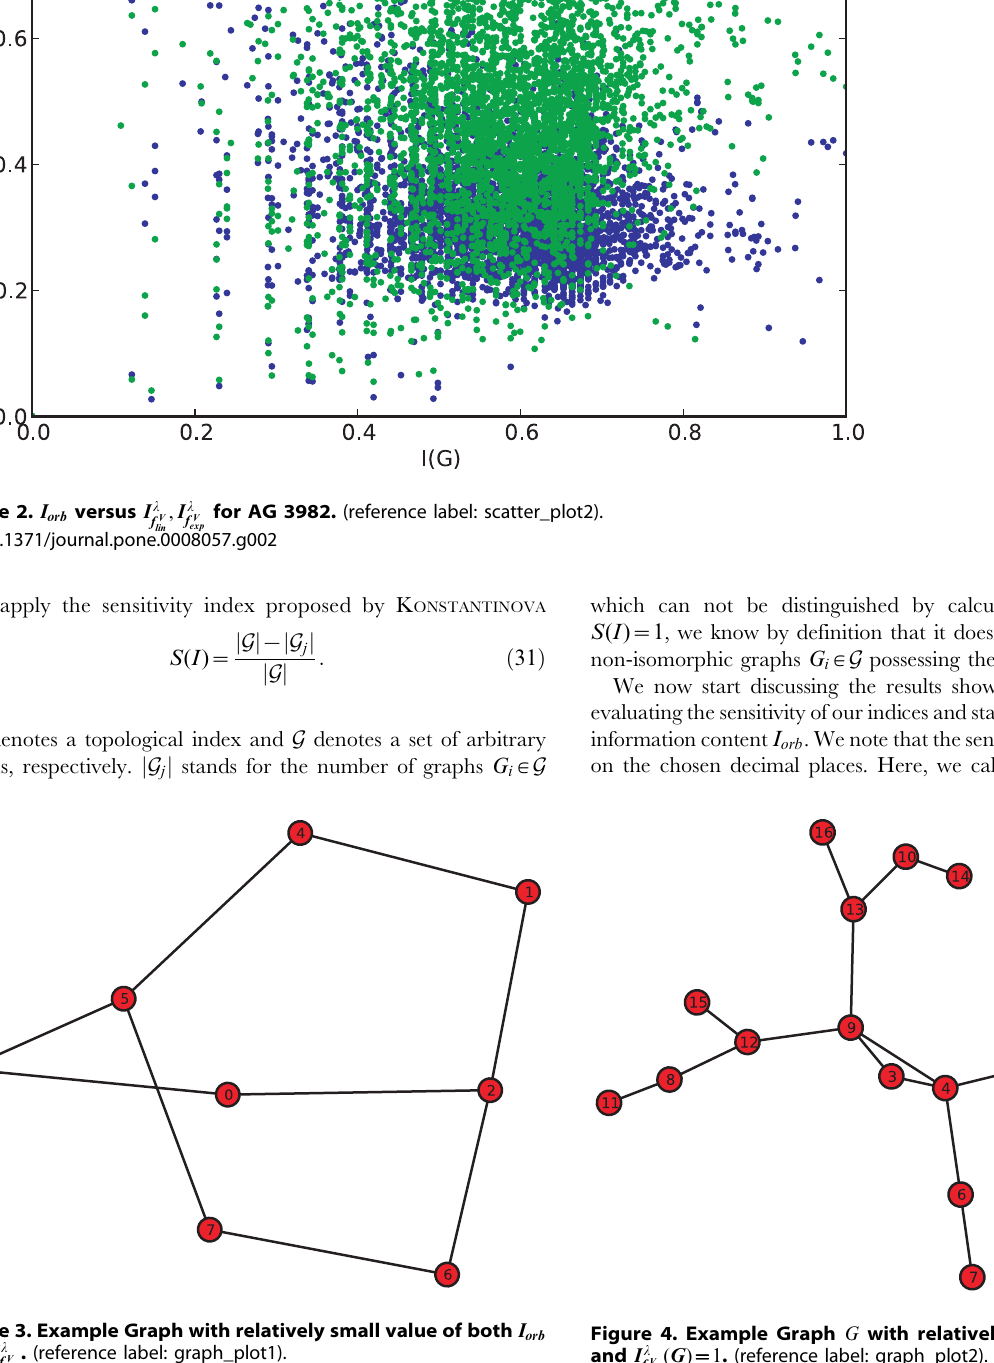
Figure 4. Example Graph G with relatively large value of I orb and I l ( G ) ~~~~~~ 1 . (reference label: f V exp